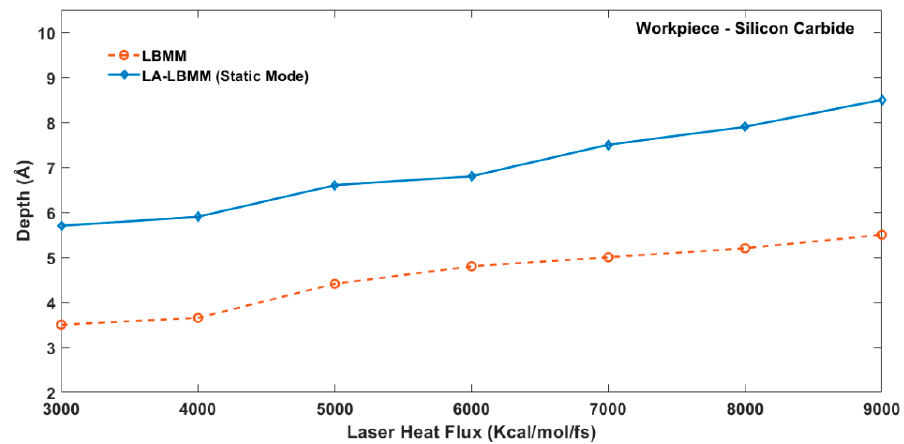
Figure 9. Variation in Cavity Depth with respect to Heat Flux during the LBMM Process and LA-LBMM Process (Static Mode) on SiC Substrate.